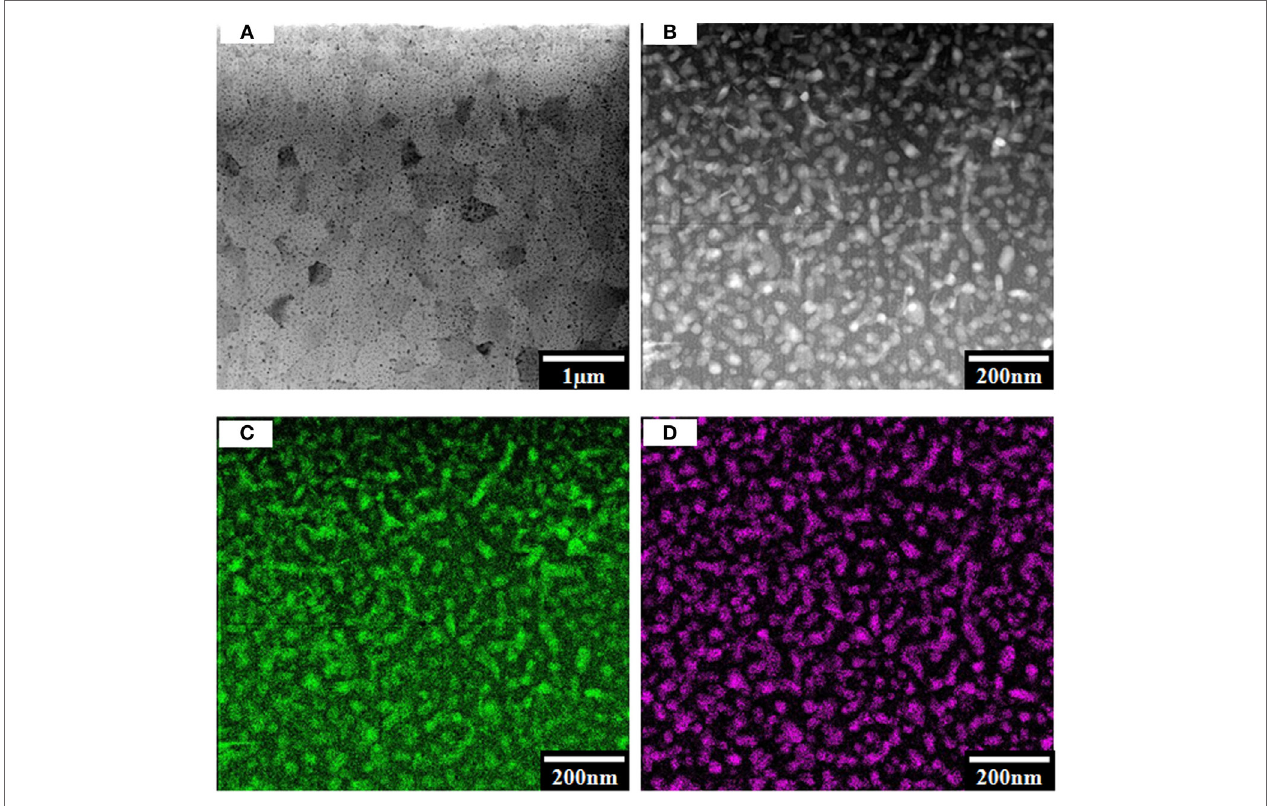
FigUre 5 | TeM images showing microstructure and elemental mapping of composition #5 after holding at 1050°c for 4.0 h: (a) overview of microstructure; (B) high-magnification image showing the fine crystals; (c) al map of (B); (D) Ti map of (B)